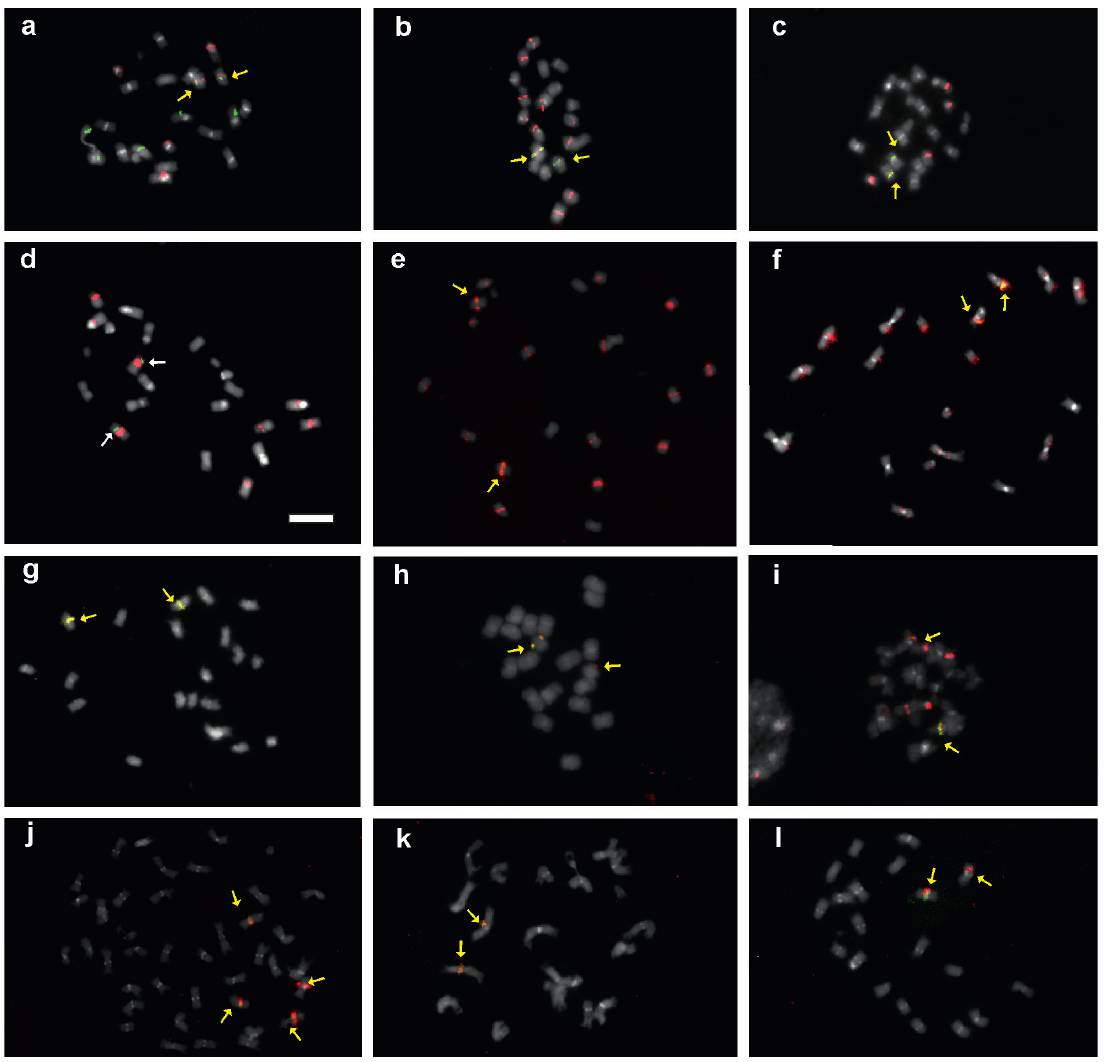
Figure 4. Somatic metaphases in representative species of different sections of Arachis after double fluorescent in situ hybridization (FISH) with clone 119 and 5S rDNA markers. The clone 119 loci are illustrated by the red signals and the 5S rDNA loci by the green signals. DAPI counterstaining in gray is highlighting the heterochromatin bands. The yellow arrows illustrate the position where both markers are linked signals in chromosome #3, whereas white arrows show when both markers are located on different positions. a- A. batizocoi (Arachis, K genome); b- A. benensis (Arachis, F genome); c- A. duranensis (Arachis, A genome); d- A. glandulifera (Arachis, D genome); e- A. ipaënsis (Arachis, B genome); f- A. praecox (Arachis, G genome); g- A. lignosa (Procumbentes) ; h. A. burkartii (Rhizomatosae); i- A. porphyrocalyx (Erectoides); j- A. nitida (Rhizomatosae); k- A. paraguariensisparaguariensis (Erectoides); l- A. matiensis (Procumbentes). Scale bar 5